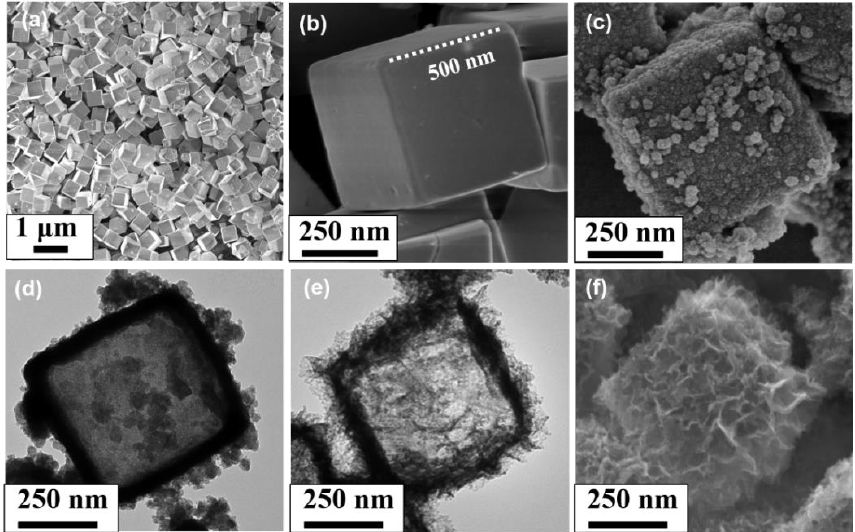
Figure 3. SEM images of ( a , b ) Cu 2 O and ( c ) NiO NCs; TEM images of prepared ( d ) NiO NCs and ( e ) Co 3 O 4 NCs; ( f ) SEM image of prepared Co 3 O 4 NCs.